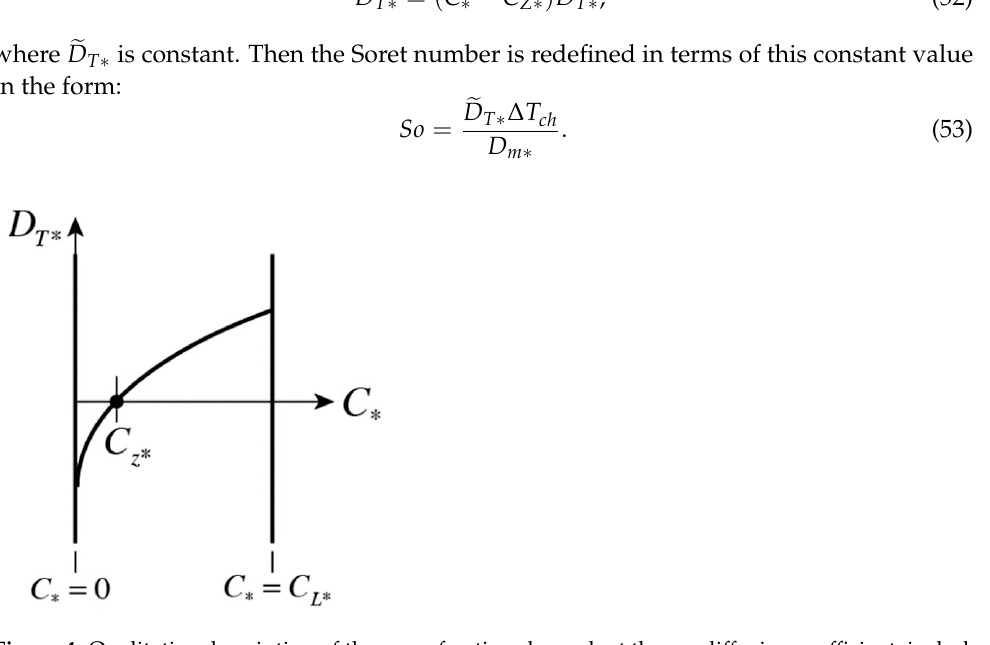
Figure 4. Qualitative description of the mass-fraction-dependent thermodiffusion coefficient, in- cluding negative values.